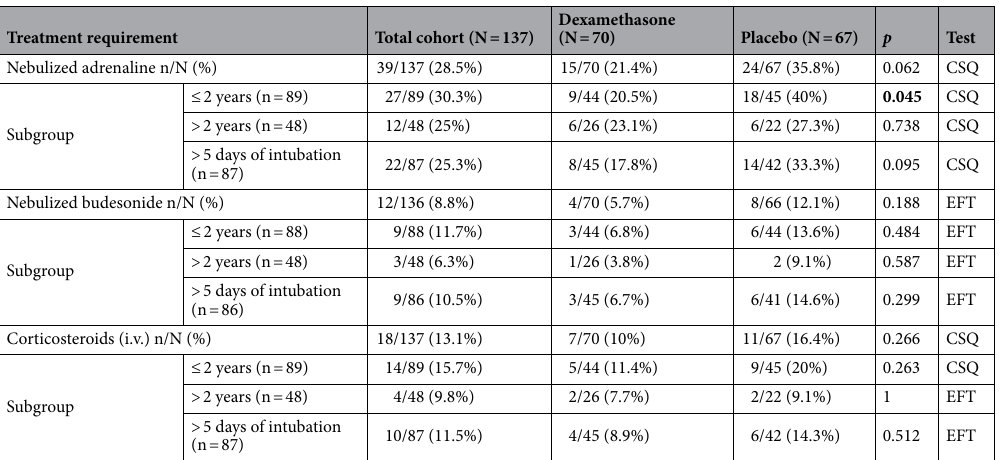
Table 4. Treatment requirements for UAO symptoms between treatment groups and subgroups within 48 h from extubation. Chi-squared Test (CSQ) and Exact Fisher Test (EFT) test were used. Statistically significant values appear in